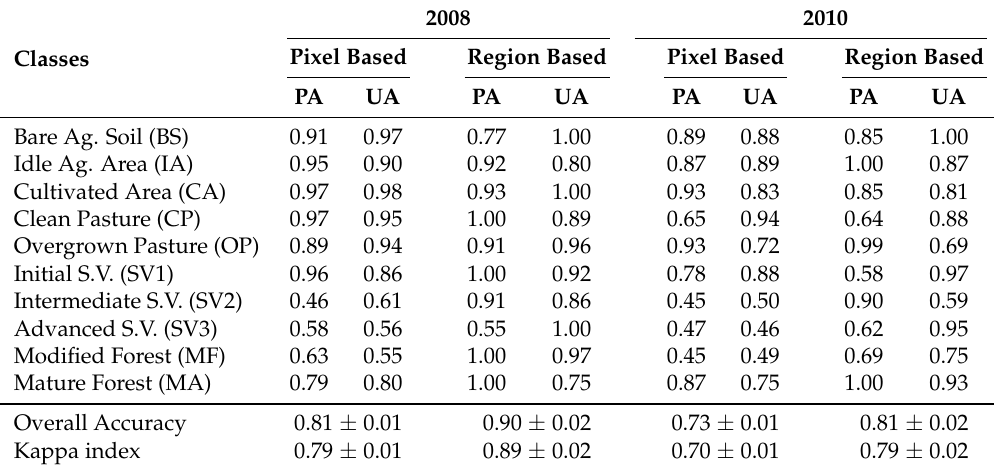
Table 5. Mean accuracy values of land cover classes of L1 based land cover